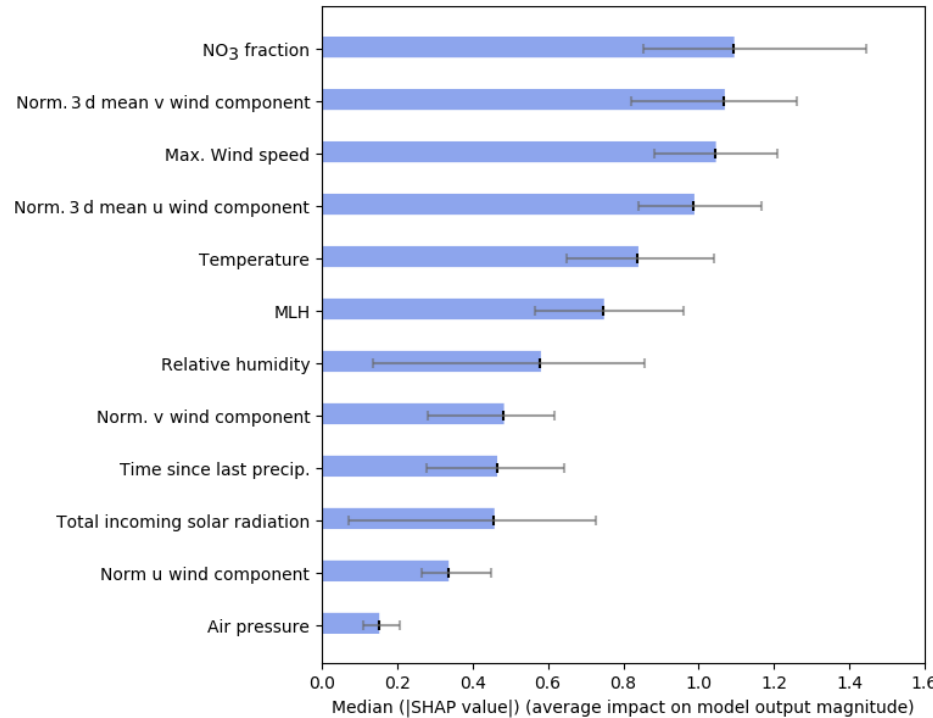
Figure 4. Ranked median SHAP values of the model input features, i.e. the average absolute value that a feature adds to the final model outcome, referring to the total PM 1 model [µg/m 3 ] (Lundberg et al., 2018). Horizontal lines indicate the variability between model